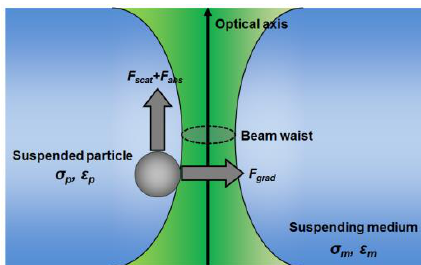
Figure 3. Trapping of a single particle by optical tweezers. Reproduced from [97], with the permission of The Royal Society of Chemistry (2011).